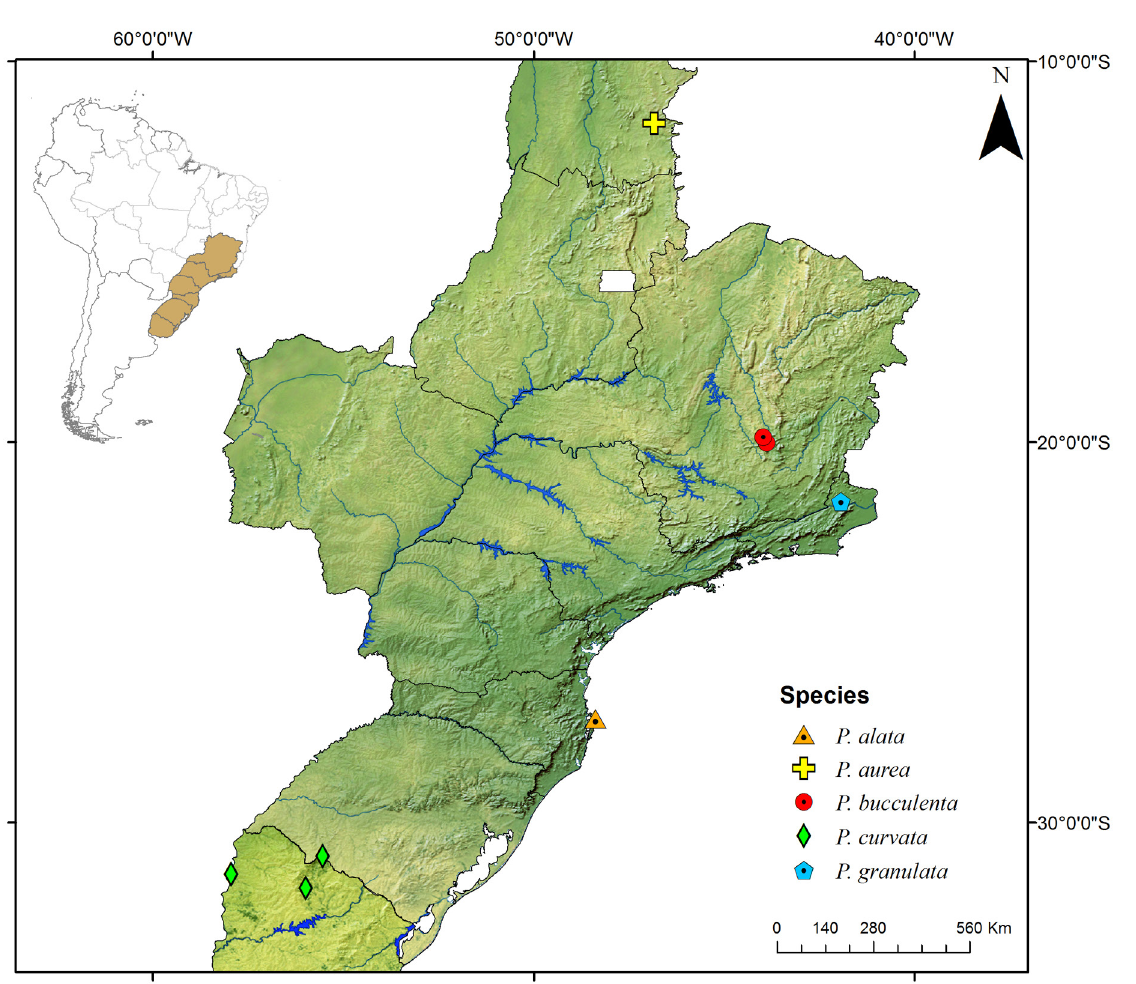
Fig. 190. Distribution map of the species Pseudonannolene alata sp. nov., P. aurea sp. nov., P.